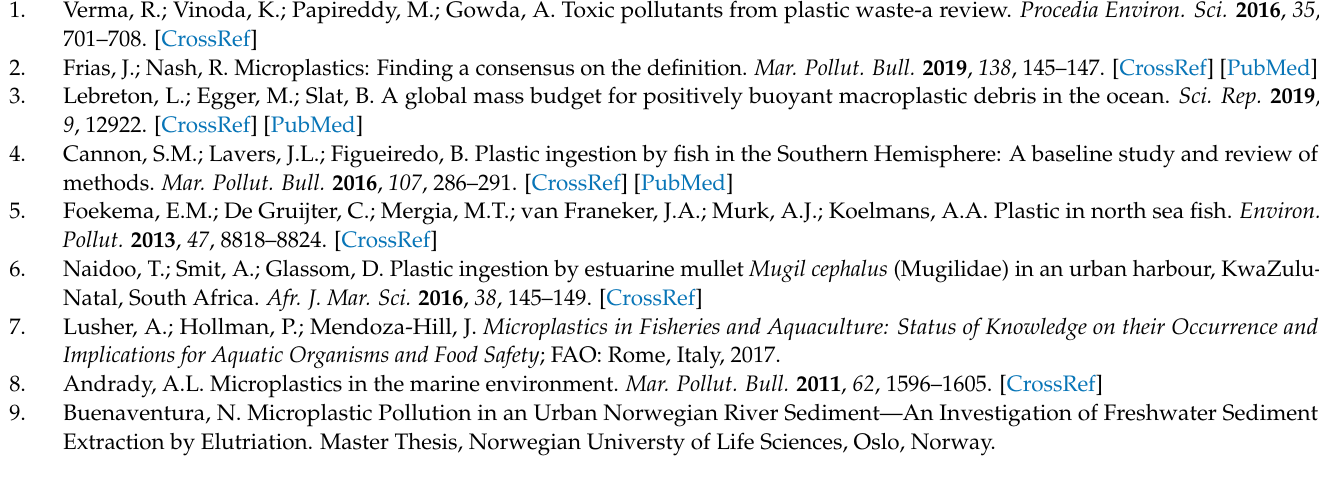
test, Table S2: HDPE content in feed used to determine microplastic effects on gene expression and histopathology, Table S3: Nutrient composition of base shrimp feed, Table S4: Details of temperature recirculation settings for qPCR, Table S5: Number of shrimp with different histopathological scores for each lesion, Table S6: The mortality rate of shrimp during the second phase of the experiment on day 28 (the sacrificed shrimp before day 28 were not